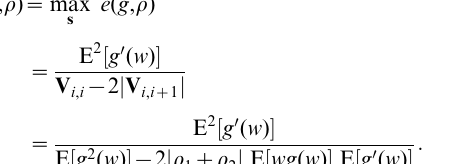
Figure 1. Eigenvector v N . An illustration of the eigenvector v N of the variance matrix V ( N ~ 200 ).